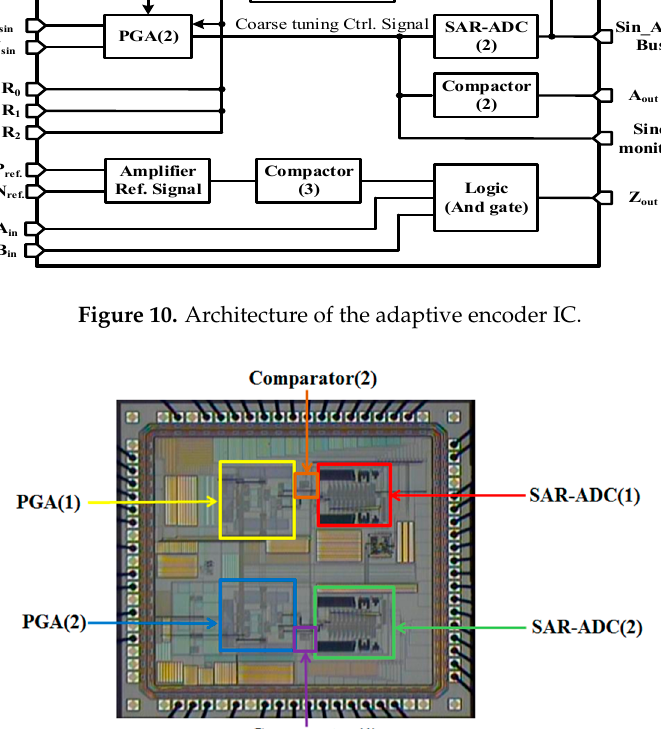
Figure 11. Die photo of the fabricated encoder IC.